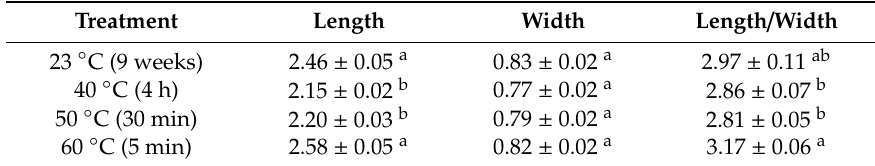
Table 4. Length, width, and ratio between length and width of SES (mm) produced from P. halepensis megagametophytes induced under di ff erent temperature